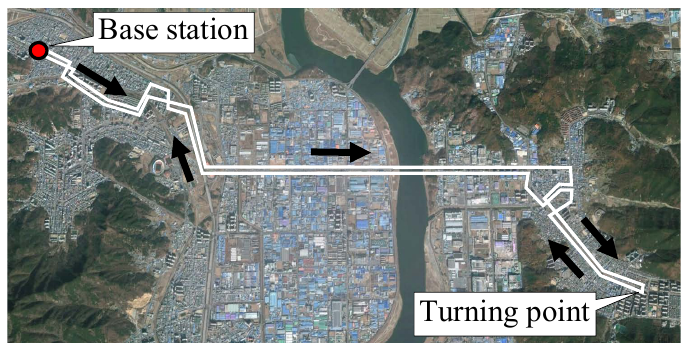
Figure 5. The OLEV service route in Gumi City.